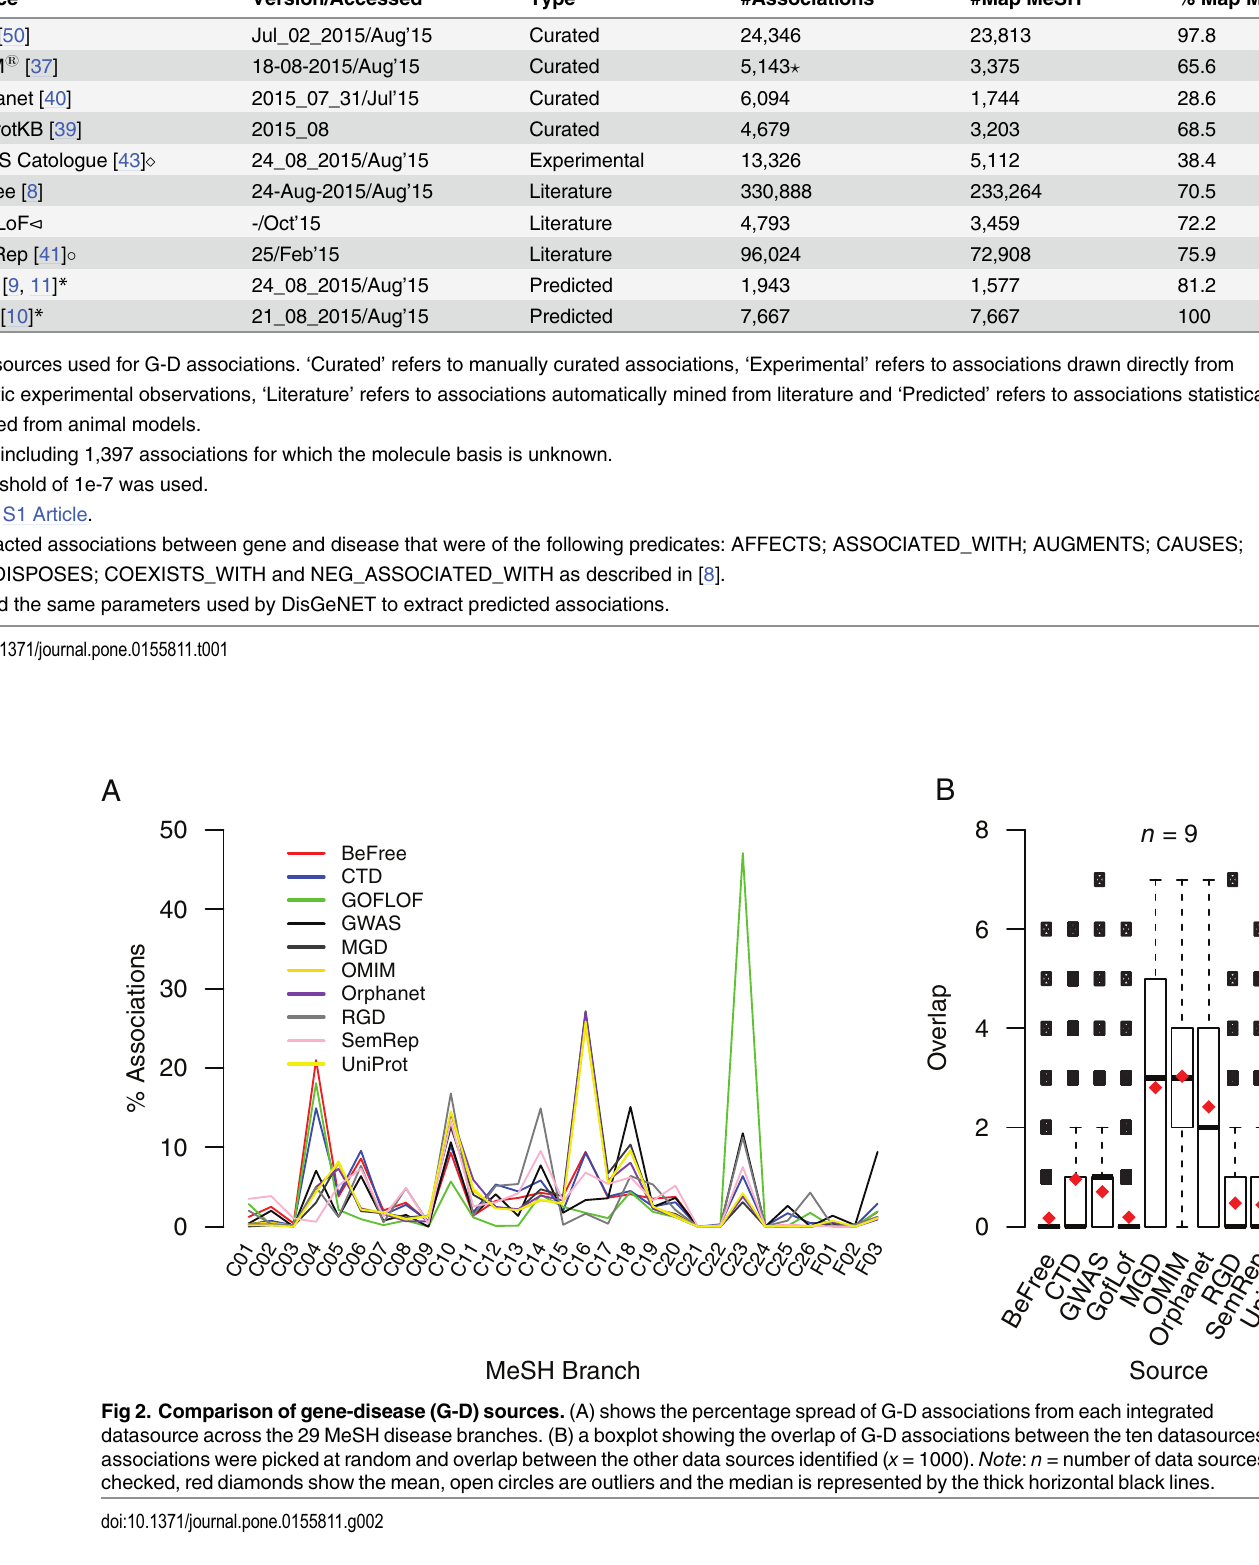
Table 1. Data sources of gene-disease associations.